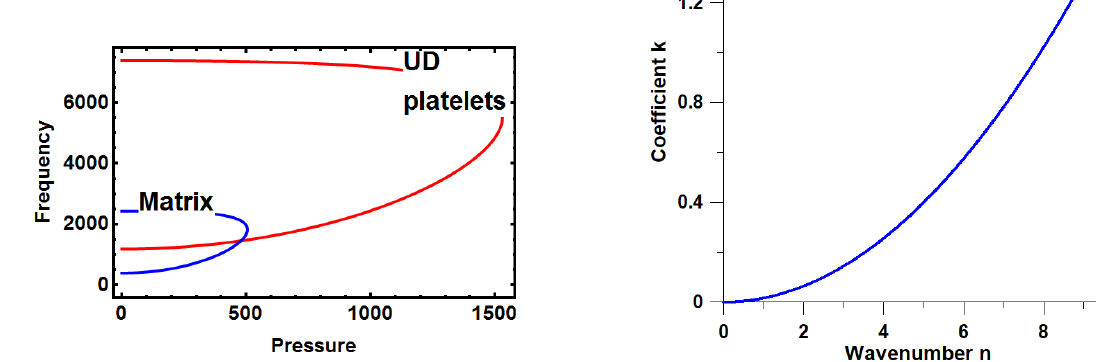
Figure 8: Variations of the coeflcient k with wavenumber n